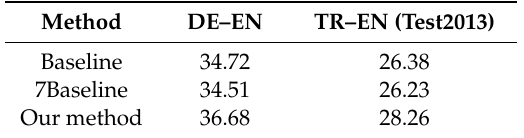
Table 5. Performance of copying original data multiple times.